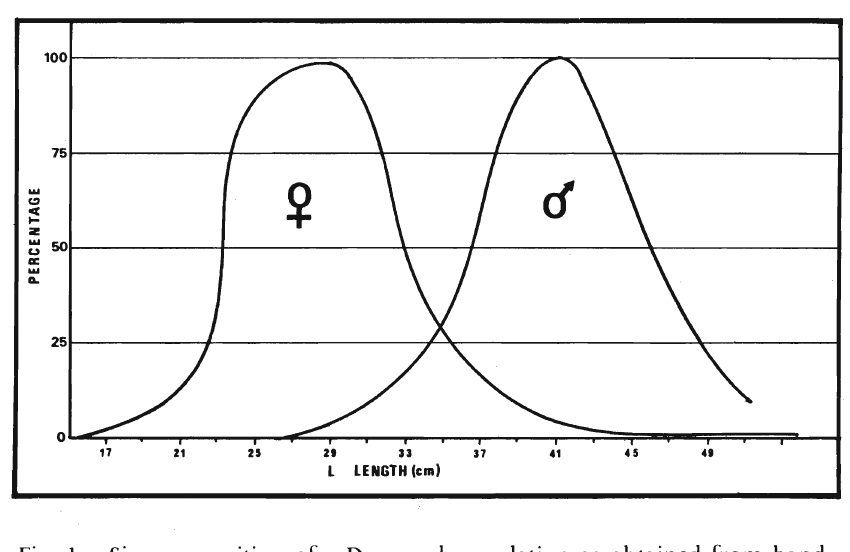
Fig. I. Size composition of a Dageraad population as obtained from hand line catches in Tsitsikama Coastal National